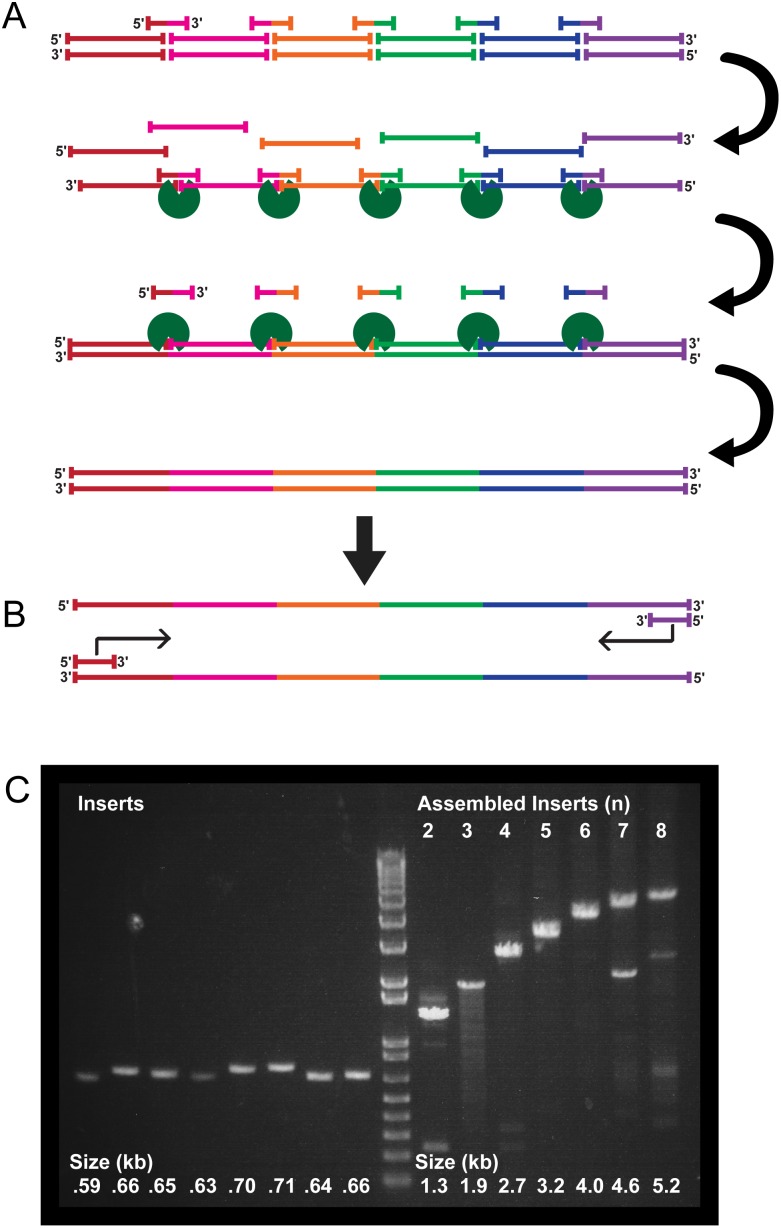
Directed Assembly of Many DNA Fragments in a Single Reaction.(A) A large number of DNA fragments can be assembled in a single reaction. The order of the inserts is determined solely by the included SOCs. Denaturation and renaturation allows SOCs to link fragments that become substrates for ligase (green). Further cycles of denaturation and renaturation, without any polymerase activity, assemble the desired double-stranded construct. (B) PCR amplification of the assembly product using a forward primer for the first fragment and a reverse primer for the last fragment yields large amounts of correctly assembled product. (C) Gel electrophoresis of PCR amplification of cycled ligation assembly products. Eight ∼650 bp DNA sequences (
Table 1
) were successfully assembled in a single reaction, in a pre-determined order and orientation, and subsequently amplified. The number of inserts (n) assembled into each product is displayed above lanes. The size (in kb) of assembled products is displayed below each lane. Products greater than 5 kb were successfully assembled in a defined order from eight DNA fragments.